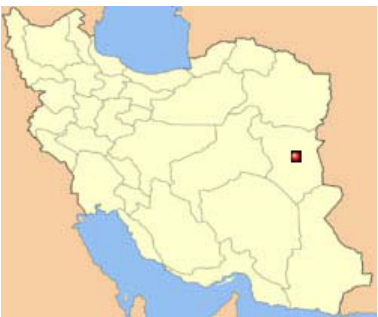
Fig. 1. The city of Brjand in east part of